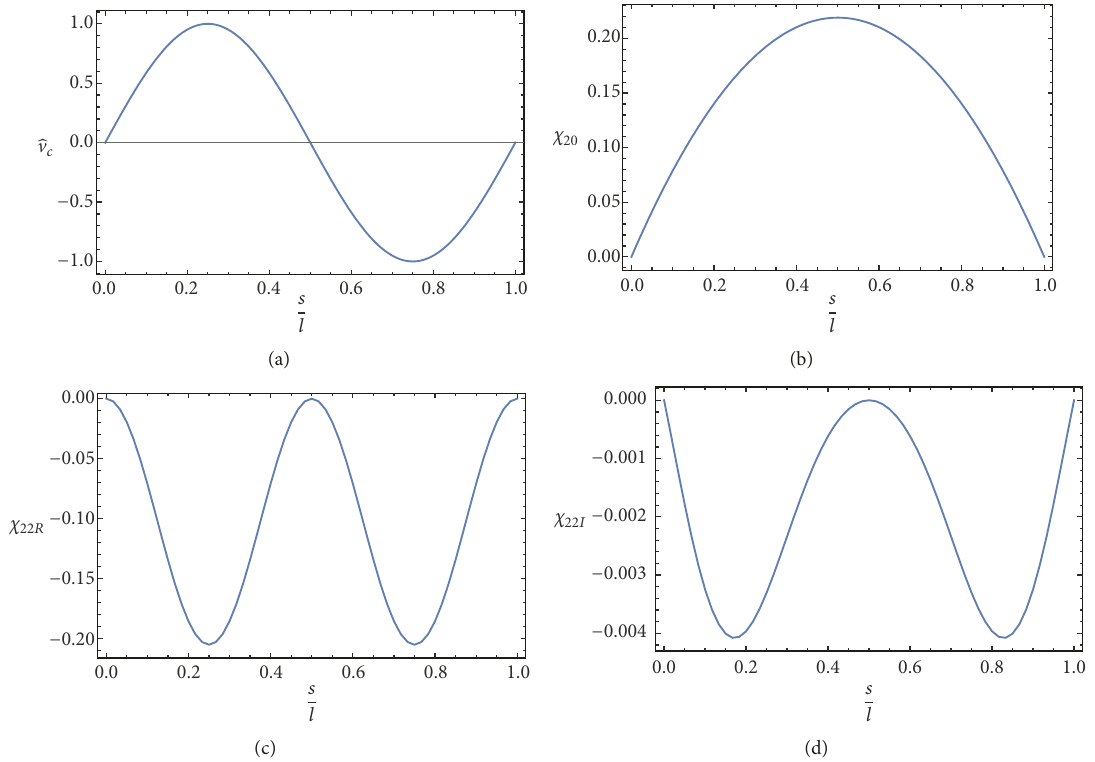
Figure 6: Case-study 2: antisymmetric mode and second order corrections.